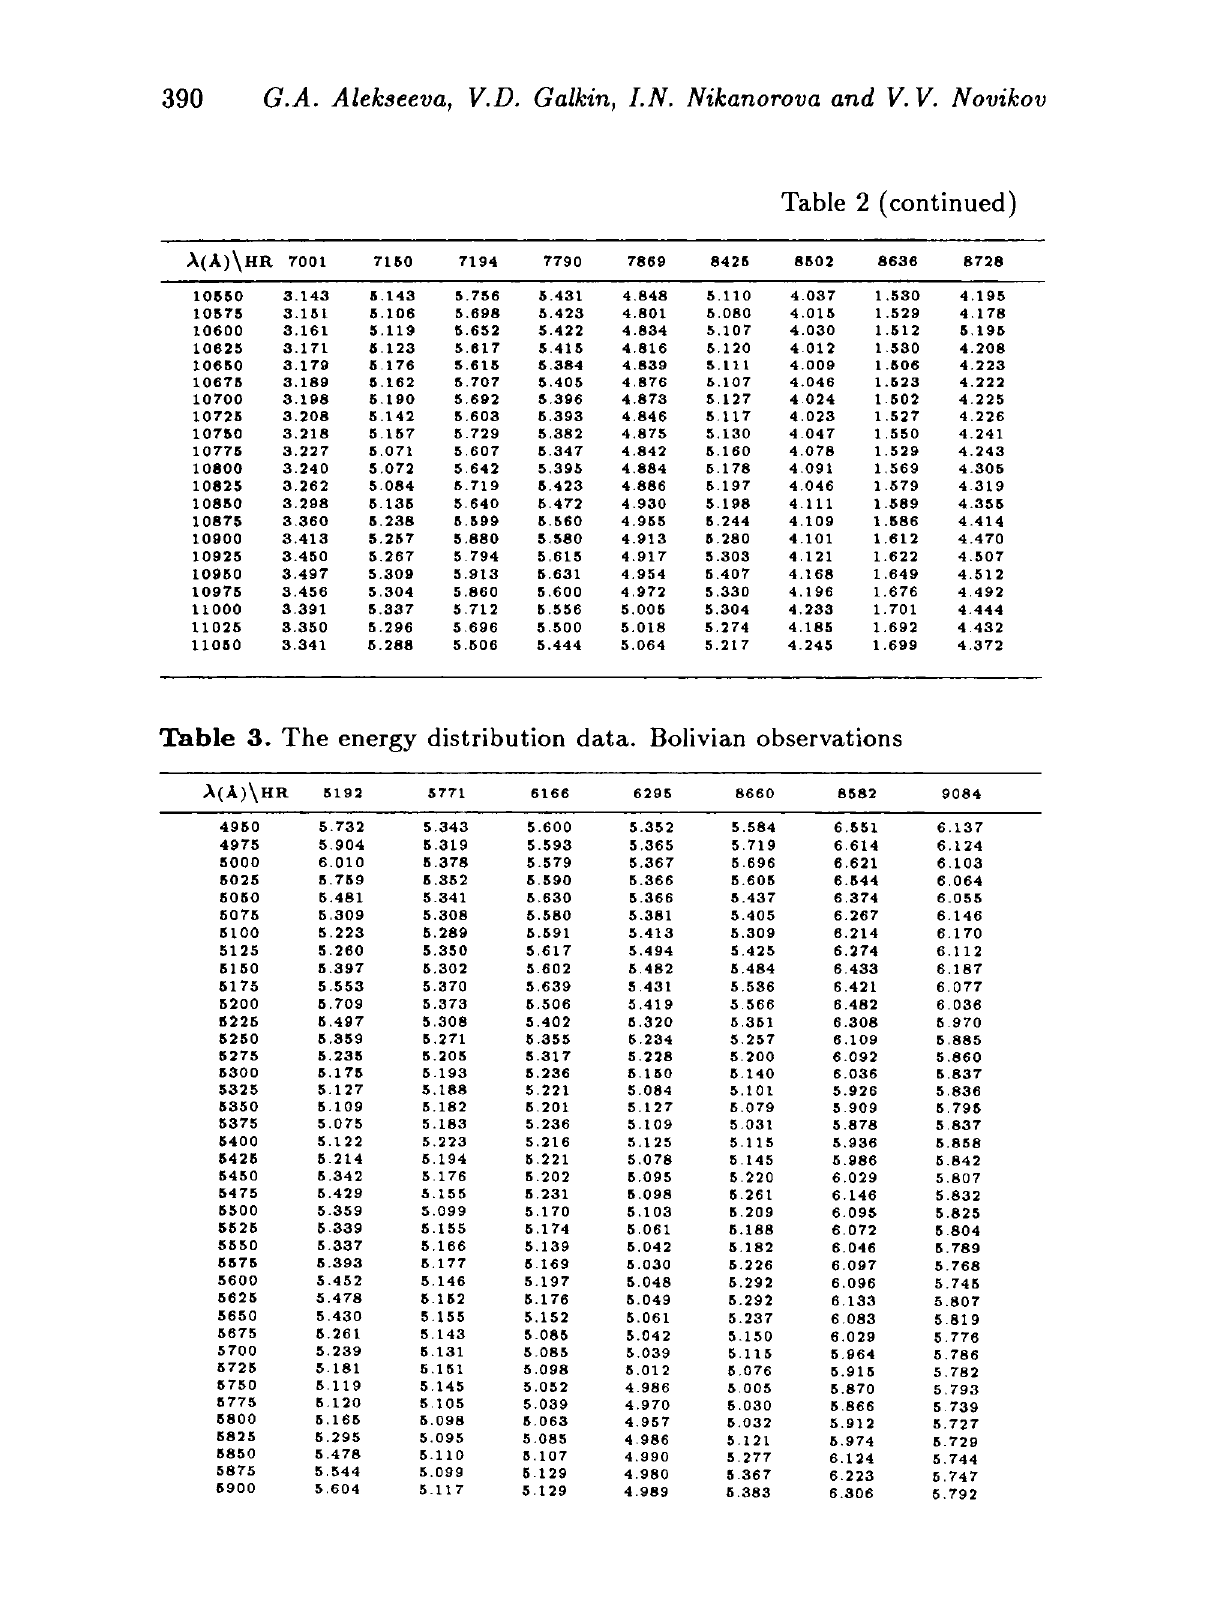
Table 3. The energy distribution data. Bolivian